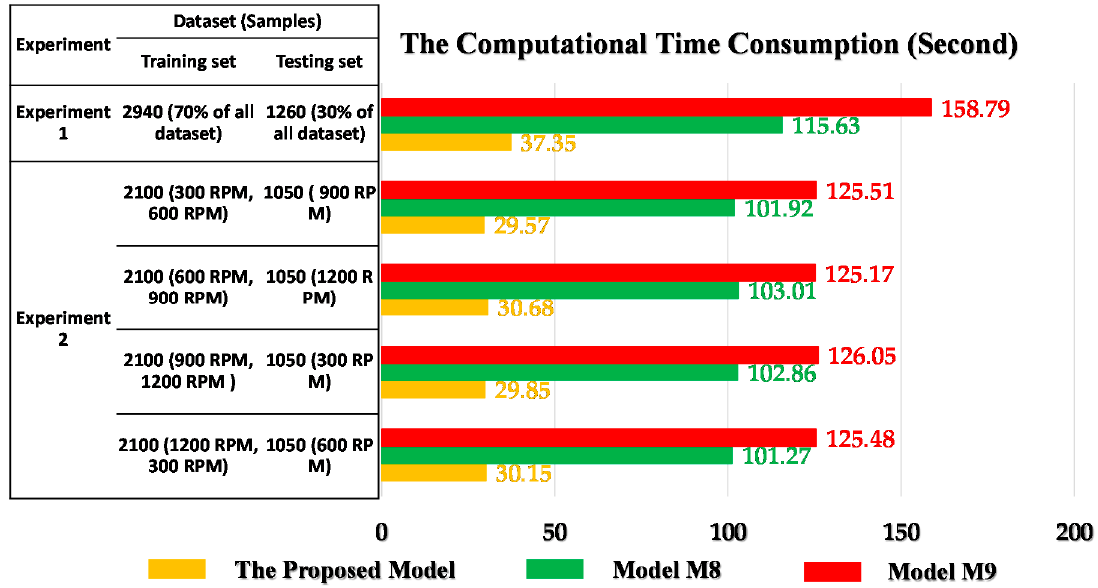
Figure 11. Visual expression of the computational time in the comparison of three models: the proposed model, M8, and M9.